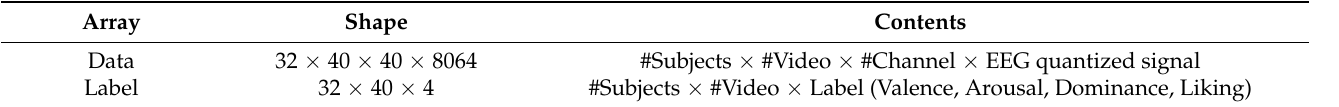
Table 2. Array contents for all 32 participants together in the DEAP